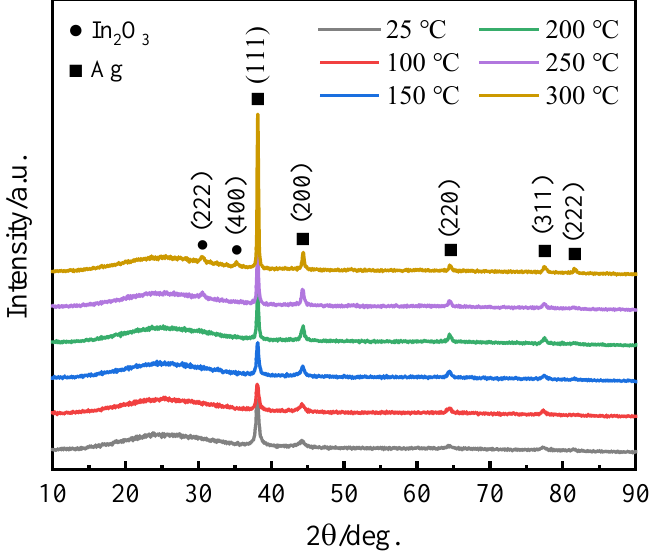
Figure 2. XRD patterns of the ITO/AgIn/ITO films at different sputtering temperatures.